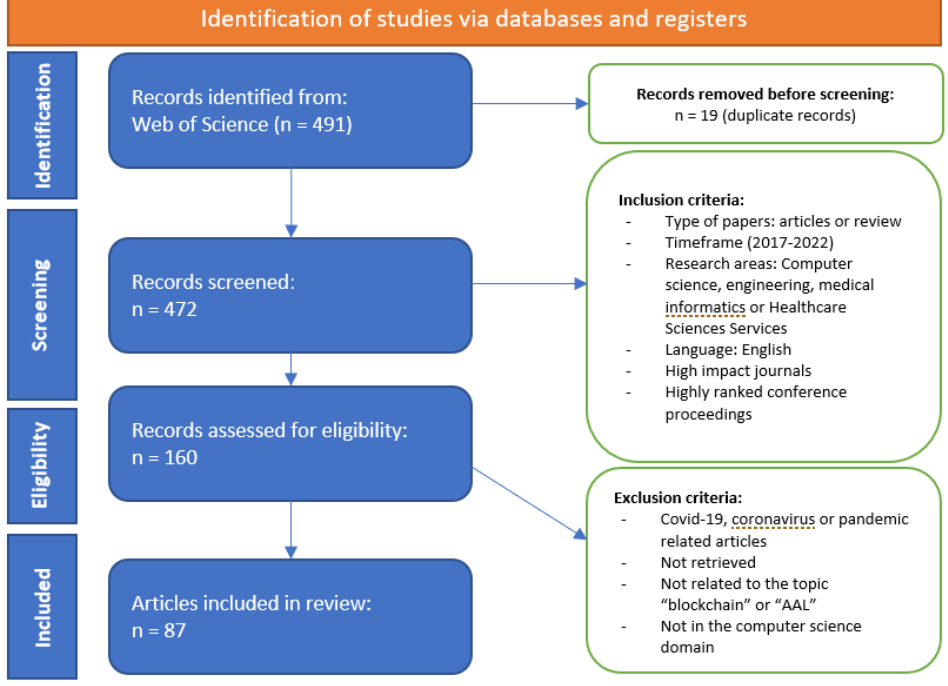
Figure 3. PRISMA 2020 flow diagram for the current study. Table 1. Criteria for including and excluding articles in the study. Screening Phase Inclusion Criteria